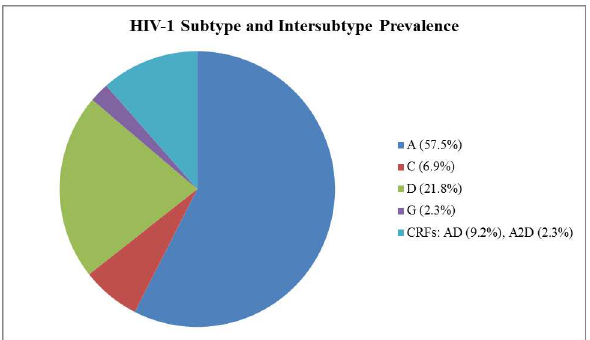
Fig 2. Summary of the subtyping and intersubtyping results of the phylogenetic analyses represented by pie chart.